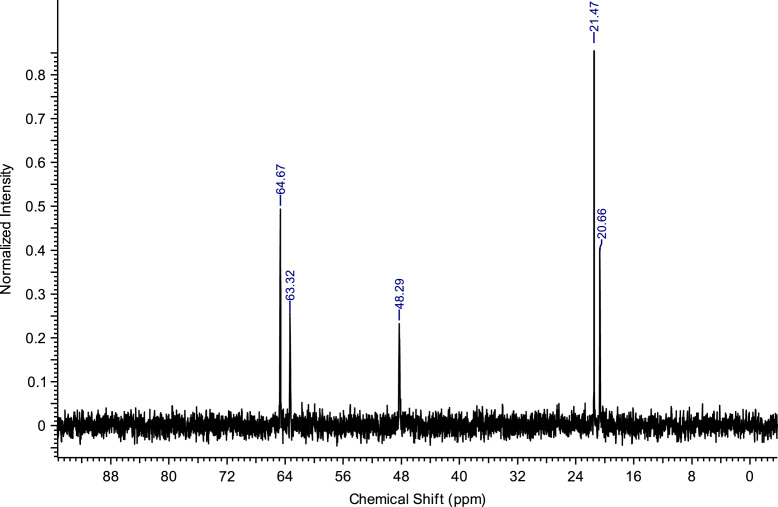
13C NMR spectra of C4(MPyrr)2Br2.